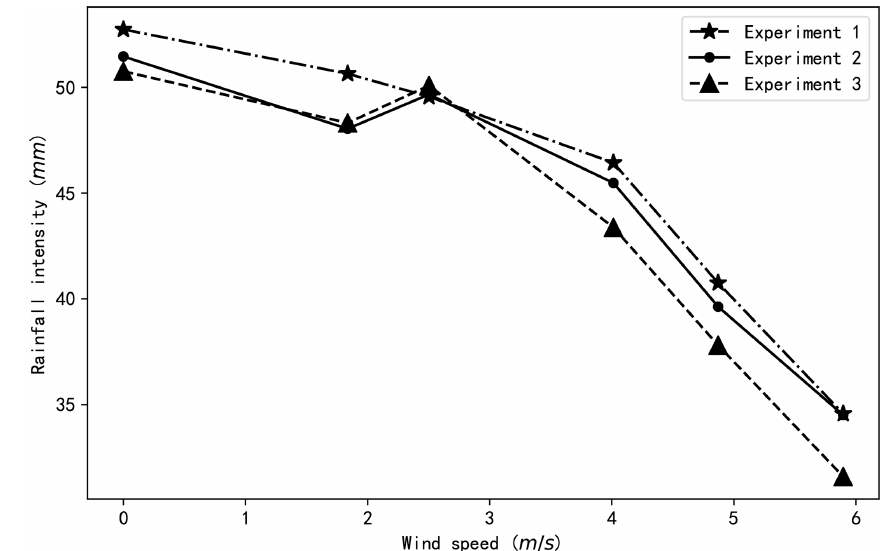
Figure 13. The rainfall intensity atop the scale model under different wind speeds for rainfall 1 of three replicate